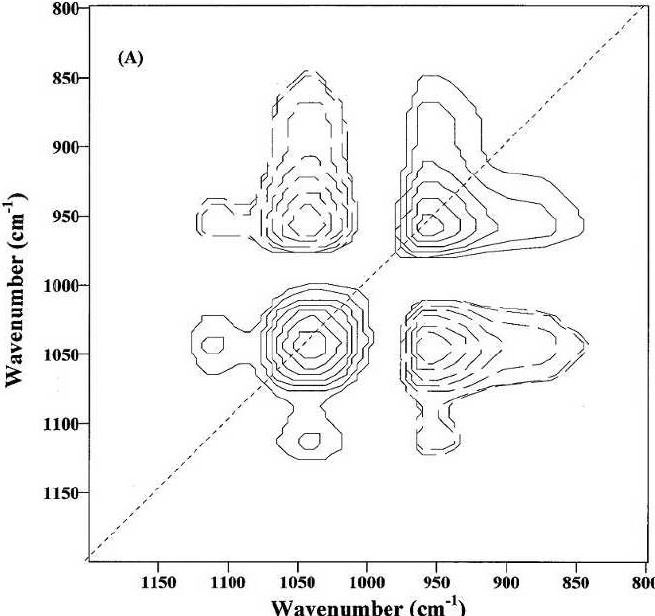
Figure 10. 2D-Corr spectrum of mature fibers in the 1200–800 cm − 1 infrared (IR) region (Reprinted with permission from [24]. Copyright 2012